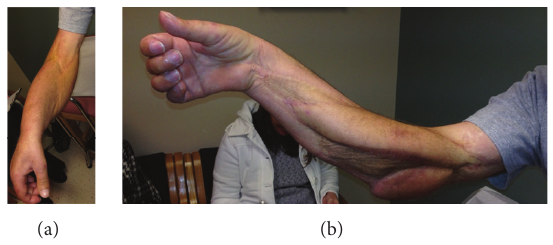
Figure 3: At most recent follow-up, the patient is sensate in the median and radial nerve distributions with weak wrist and finger flexion and